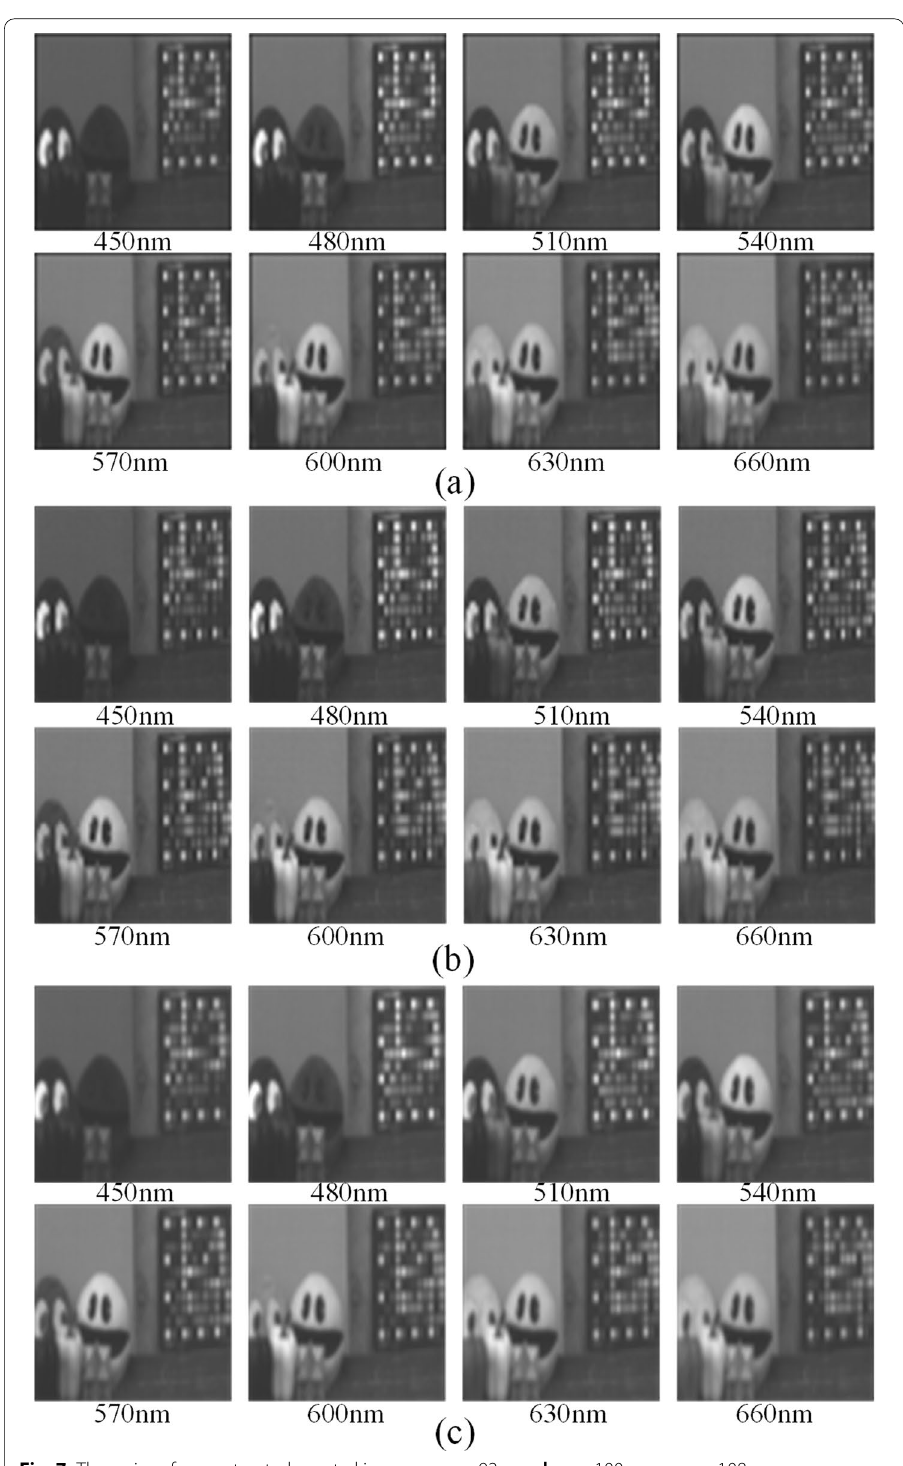
Fig. 7 The series of reconstructed spectral images, a z o